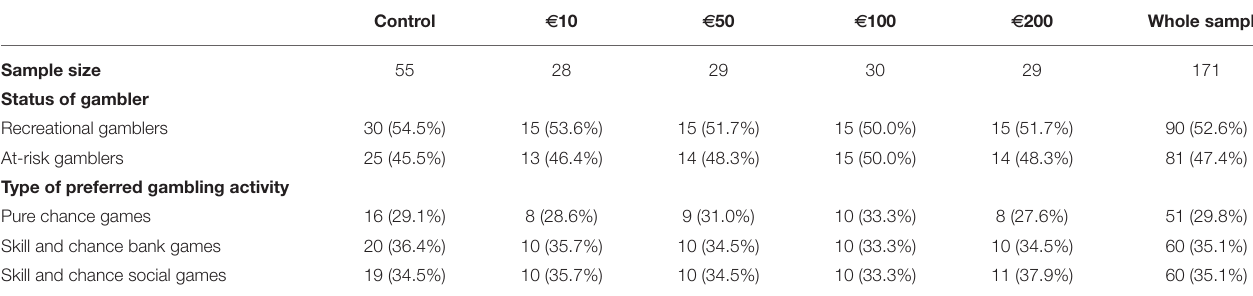
TABLE 1 | Sample size of each condition according to the stratification variables (status of gambler and type of preferred gambling activity).